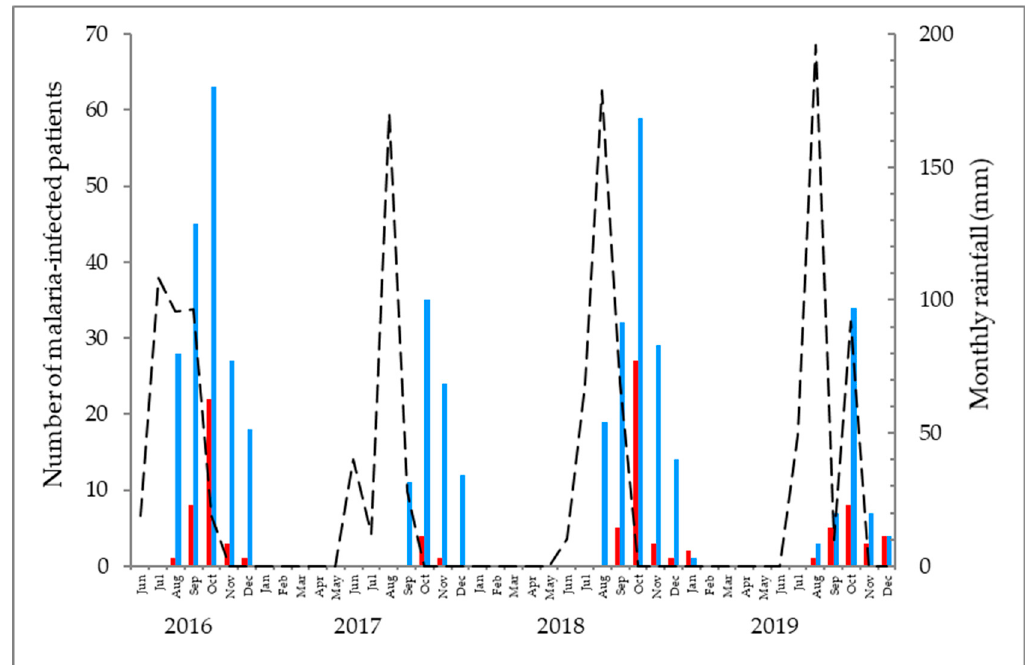
Figure 3. The number of patients with uncomplicated or severe malaria admitted in Kiffa Regional Hospital, southern Mauritania, in 2016–2019 (left vertical axis, coloured bars). The hospital opened on 1 August 2016. Laboratory-confirmed malaria cases were seen from August to December in 2016–2019. Rainfall occurred only between June and September or October in 2016–2019 (right vertical axis, broken line). Blue bar, uncomplicated malaria; red bar, severe malaria; broken line, monthly rainfall (mm).